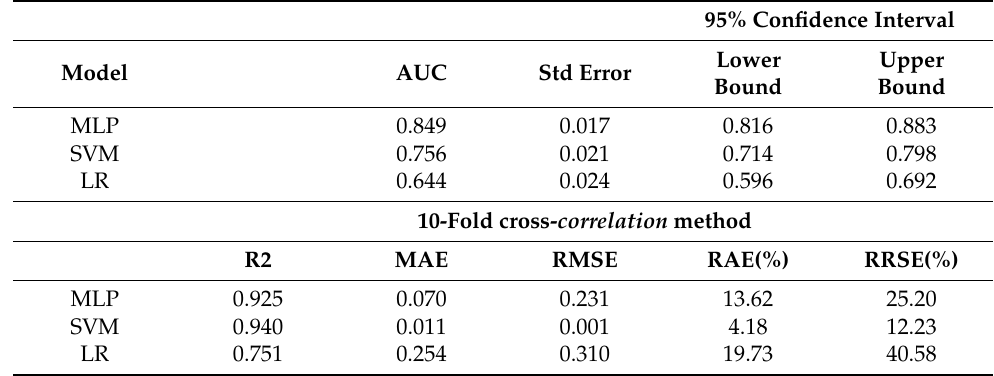
Table 2. Model validation result: area under the curve and CFS 10-fold cross